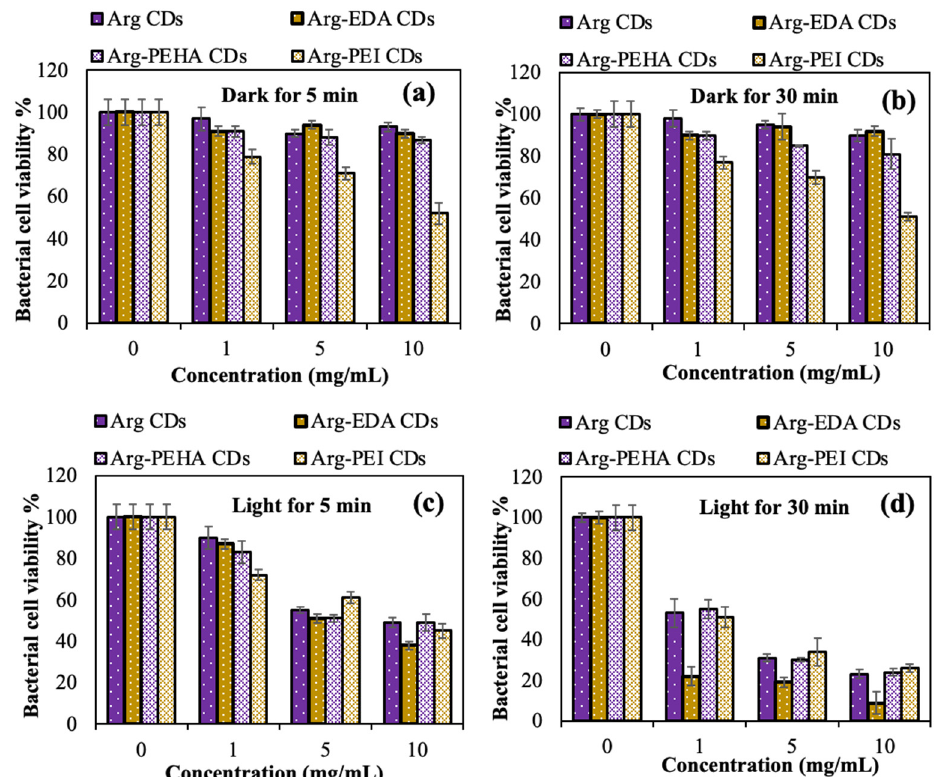
Figure 7. Photodynamic antibacterial activity of 1, 5, and 10 mg/mL concentrations of Arg, Arg-EDA, Arg-PEHA, and Arg-PEI CDs under dark conditions for ( a ) 5 min and ( b ) 30 min, and UV light irradiation for ( c ) 5 min and ( d ) 30 min against E. coli (gram -).